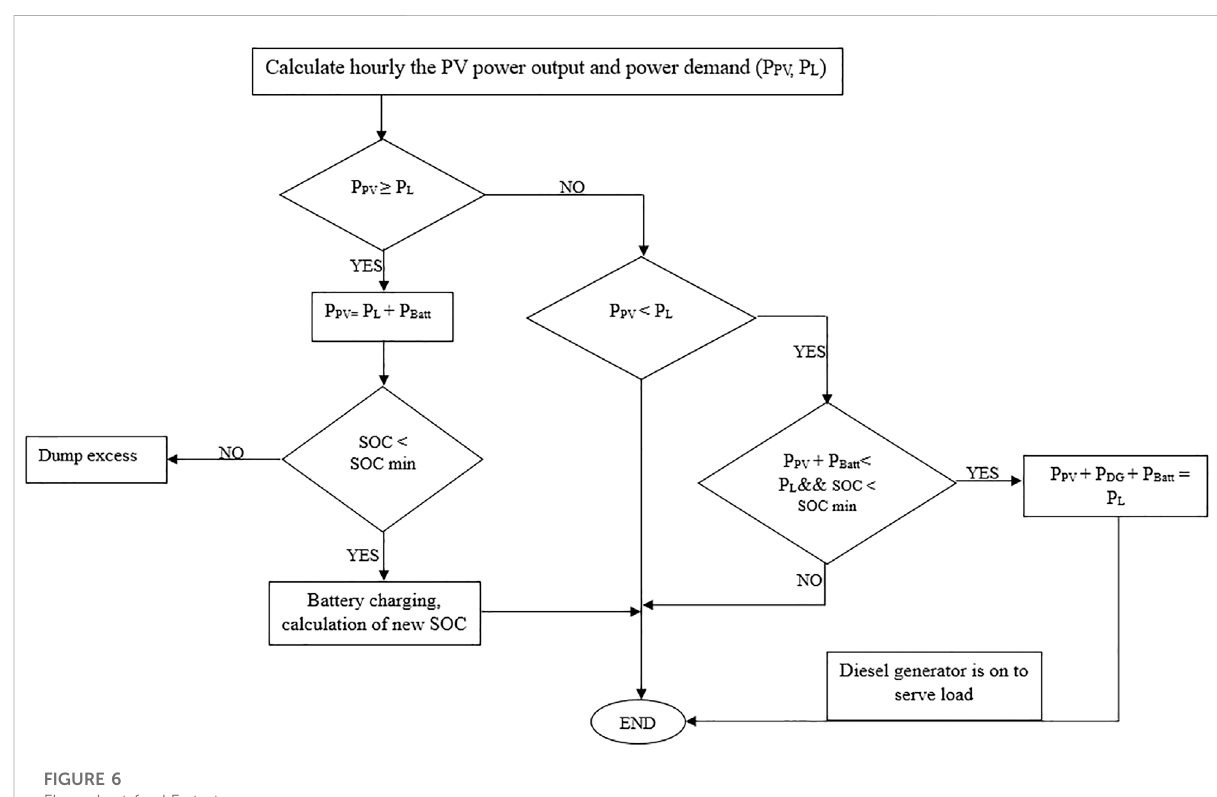
FIGURE 6 Flow chart for LF